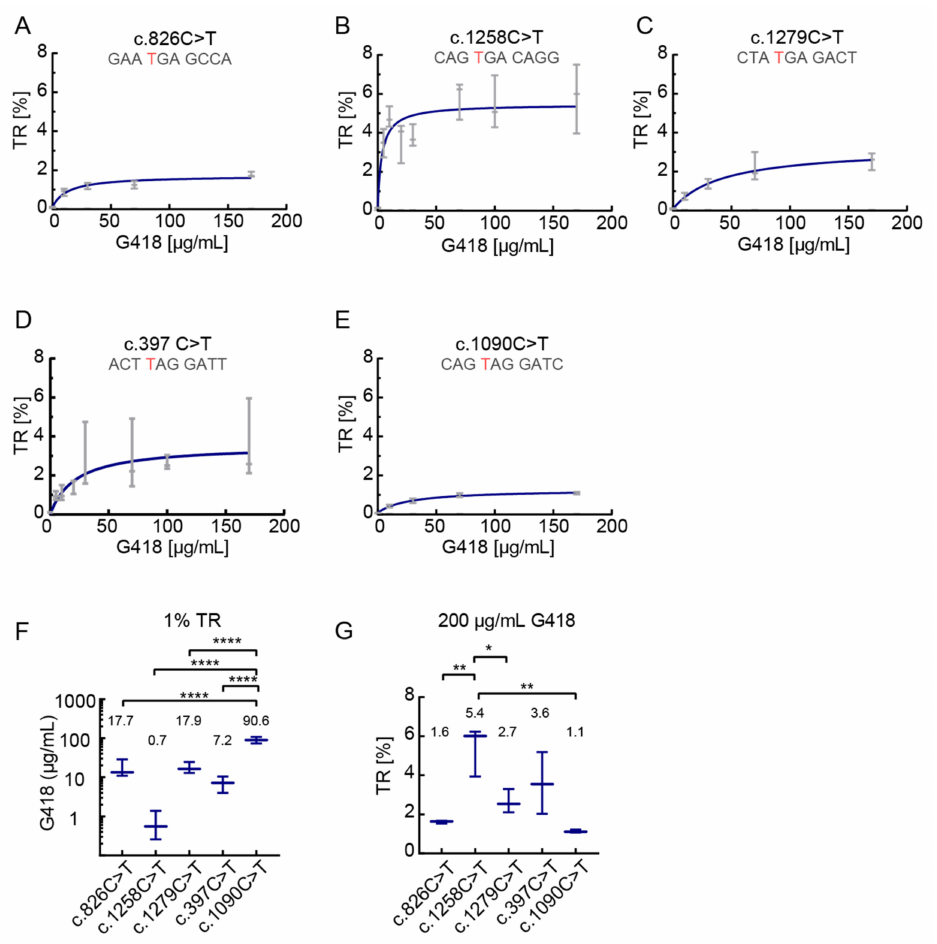
Figure 2. Dose-response analysis of SCC-dependent translational readthrough. G418 was used for TR induction at concentrations up to 170 µ g/mL. All SCCs showed a dose-dependent increase of TR. Maximal TR induction differs between SCCs indicating SCC dependency. ( A ) The highest TR observed in c.826C>T is less than 2%. N = 3. ( B ) G418 induces high levels of TR at low